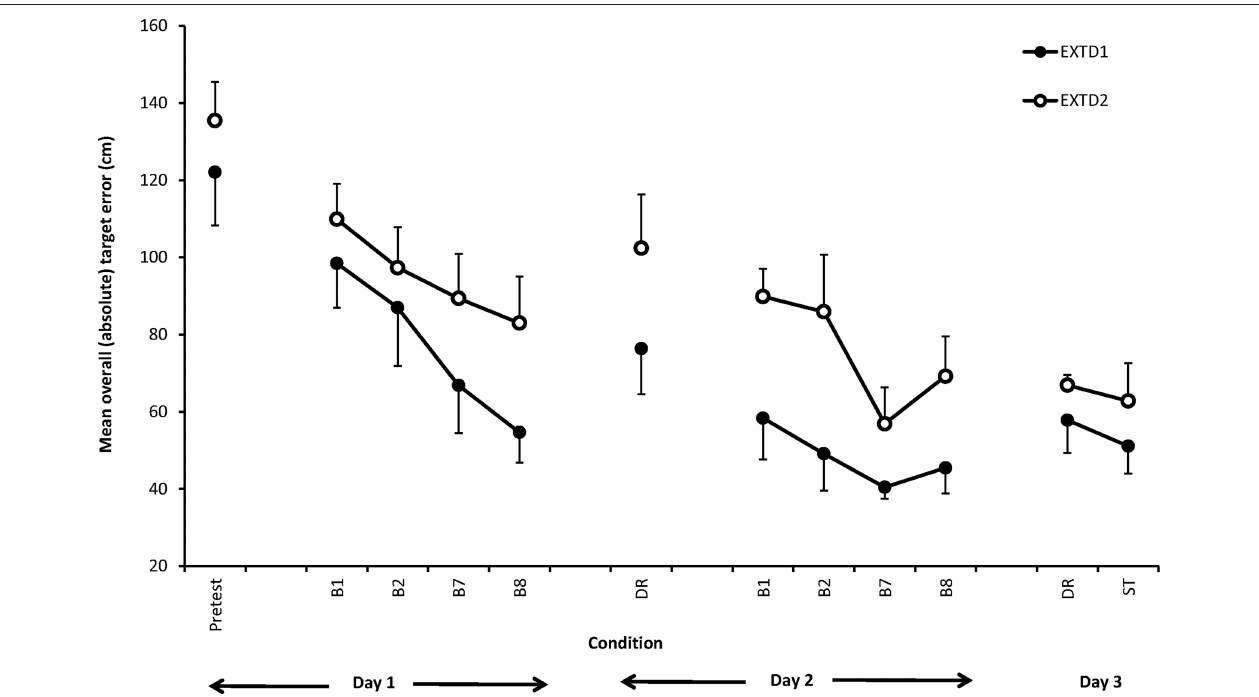
Figure 4 | average overall (absolute) target error (cm) as a function of group, day, condition (pretest, practice, delayed retention [Dr], stress [ST]), and practice block (either the first two practice blocks, B1, B2, or the last two practice blocks B7, B8) in experiment 2. Error bars represent standard error